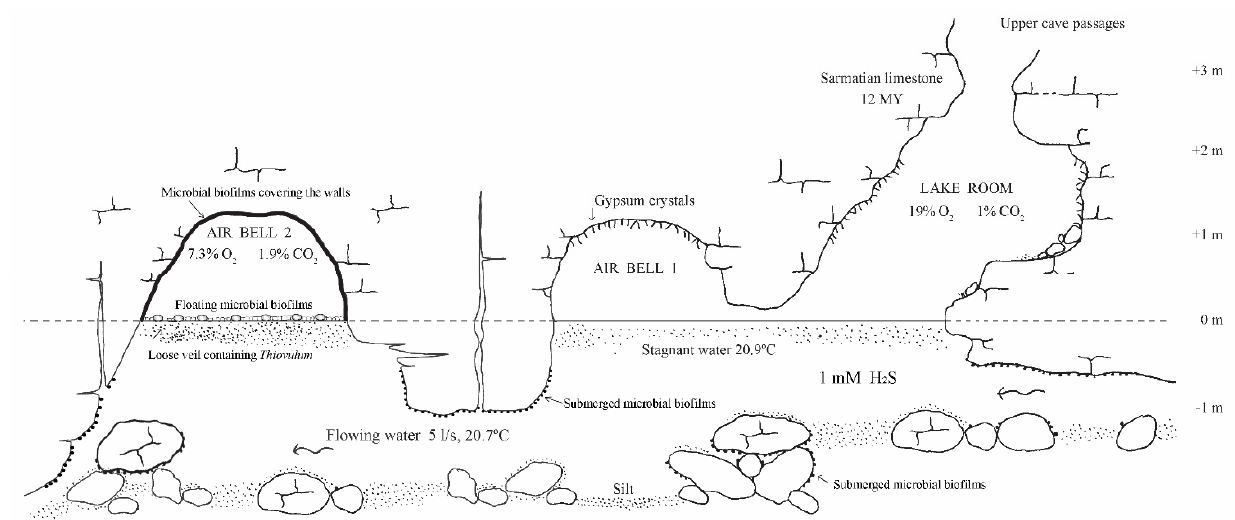
Figure 2. Longitudinal profile through the submerged cave gallery (modified after Sarbu and Popa, 1992). Some water flow is present at depths greater than 1 m, while at the surface, the water is rather stagnant and supports the growth of microorganisms in thick or loose biofilms. Anaerobic microbes attach to the cave walls, rocks, and sediments.